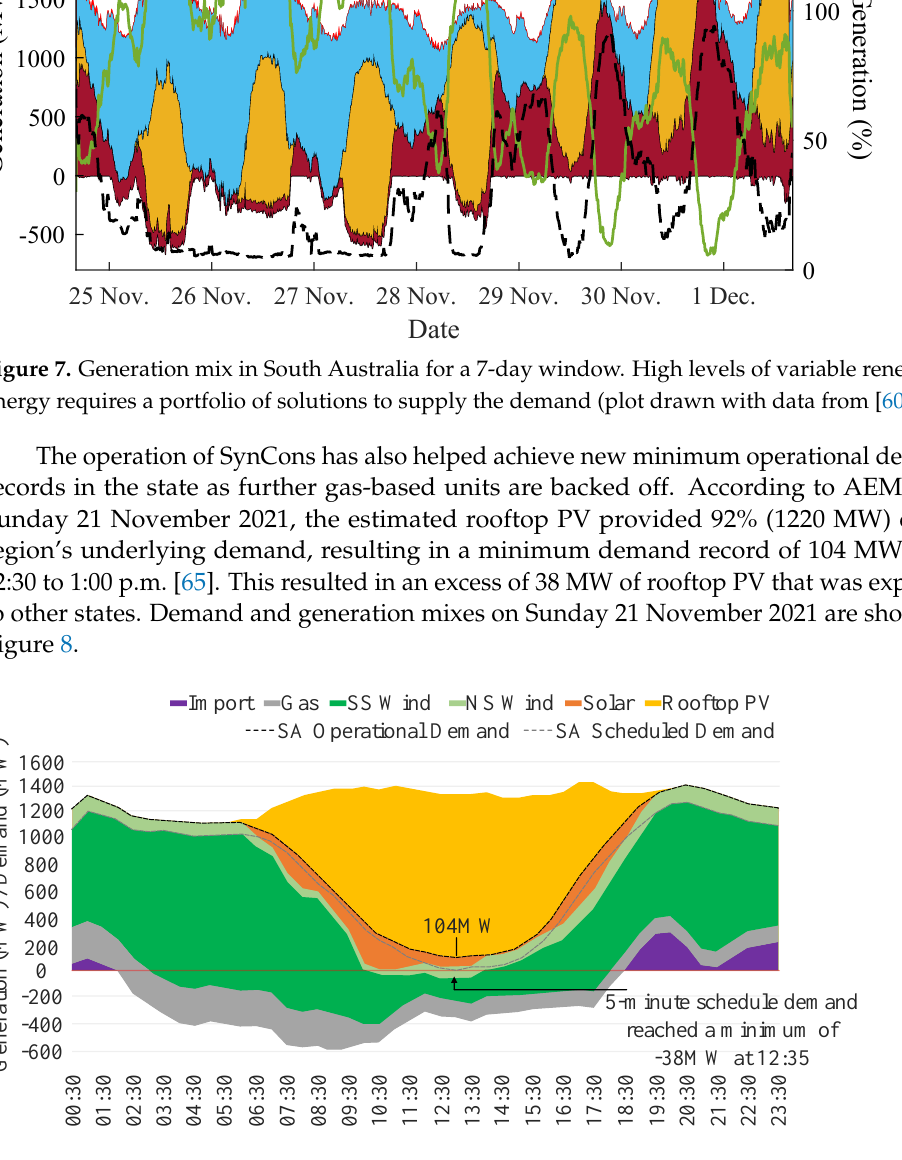
Figure 8. Negative scheduled electricity demand in South Australia, Sunday 21 November 2021